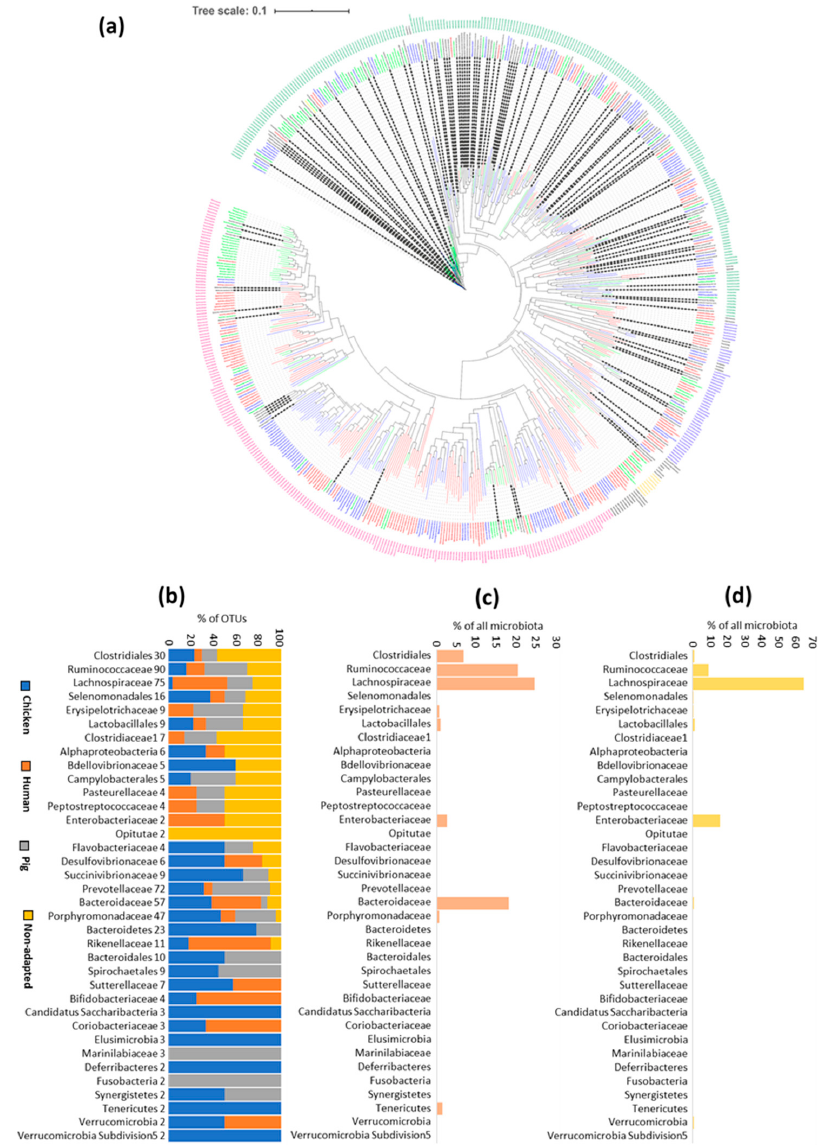
Figure 3. Distribution of host-adapted and broadly distributed OTUs to particular taxa. Panel ( a ), Clustal alignment of V3/V4 variable region sequences of 16S rRNA gene was used for comparison of 561 most common OTUs from chicken, human and pig microbiota. Branches in bold points towards OTUs present in two or more hosts. Colours of inner labels and branches indicate host adaptation—green indicates human-adapted OTUs, red—chicken-adapted OTUs, blue—pig-adapted OTUs, black and bold—host non-adapted OTUs. External labels indicate classification into families. Families in green belong to Firmicutes, magenta—Bacteroidetes, blue—Proteobacteria, yellow—Actinobacteria, black—all other phyla. Host non-adapted OTUs were randomly distributed mainly among Firmicutes and Proteobacteria. To zoom in, see Figure S1. Panel ( b ), numbers of OTUs belonging to particular taxa and their classification as host-adapted or non-adapted. Numbers next to taxon description show how many OTUs belonged to a given taxon. Non-adapted OTUs were common in taxa belonging to aerotolerant Proteobacteria or Firmicutes (see yellow colour e.g., in Campylobacterales, Pasteurellaceae or Lactobacillales), or anaerobic spore-forming Firmicutes (e.g., Lachnospiraceae, Ruminococcaceae, Peptostreptococcaceae or Clostridiaceae1). Panel ( c ), average abundance of the same taxa as in panel B in microbiota of seven-day-old broilers in commercial production. Panel ( d ), average abundance of the same taxa as in panel ( b ) in microbiota of seven-day-old chicks raised in contained facilities of VRI Brno. Only taxa with two or more OTUs are shown in panels ( b , c